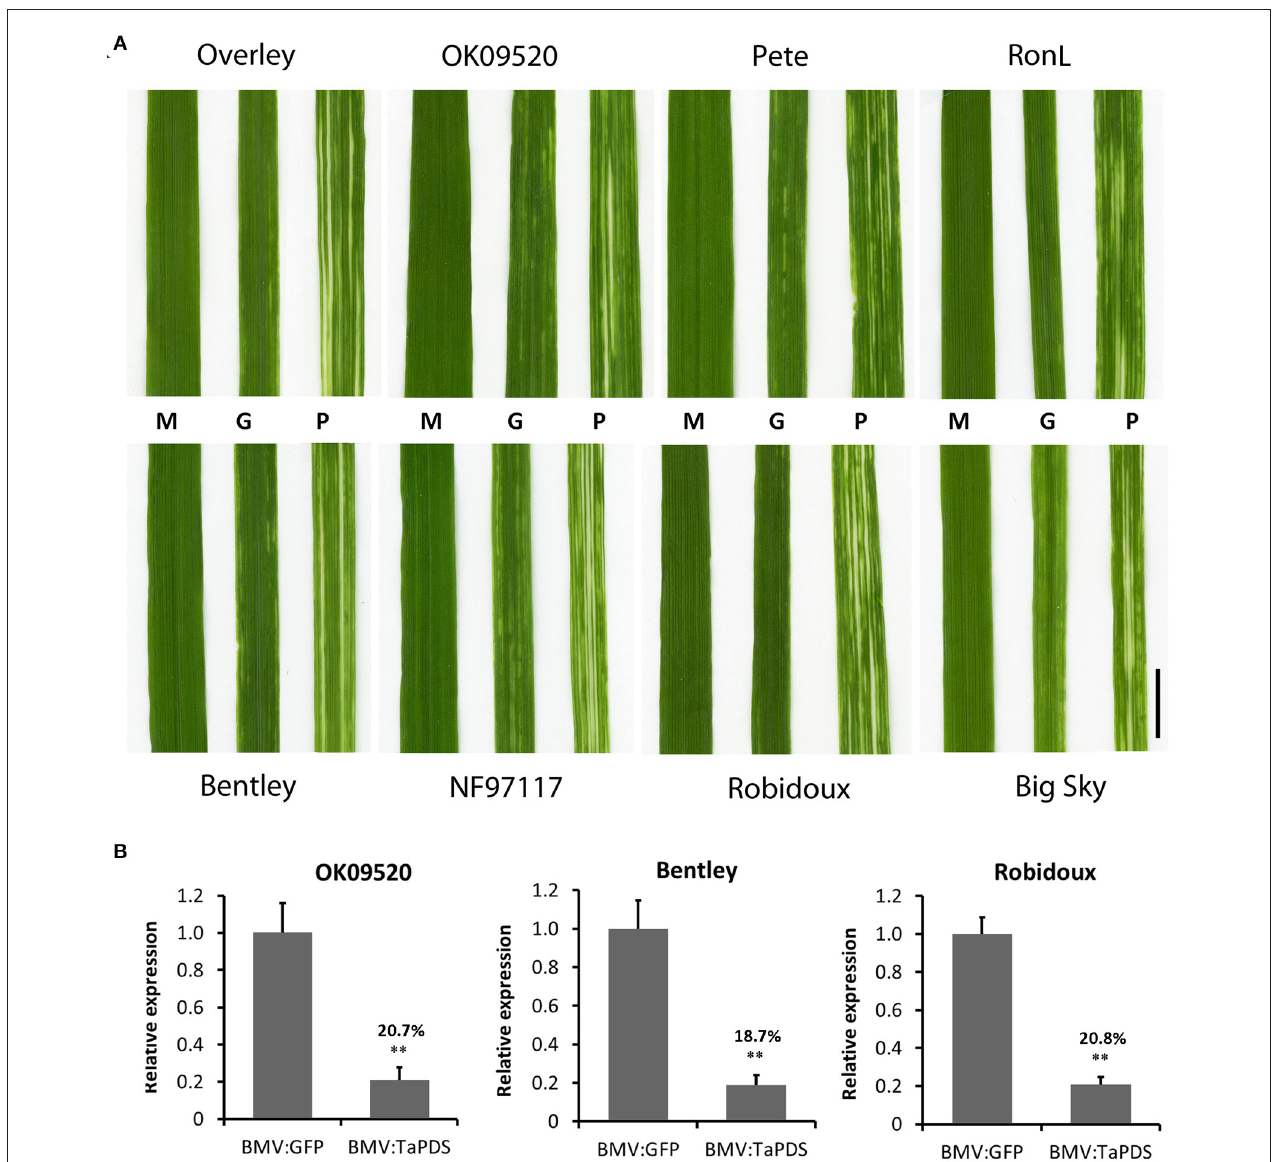
FIGURE 7 | BMVCP5-induced TaPDS silencing in eight winter wheat cultivars. (A) Images show a representative phenotype of the 3rd systemic leaf at 22 dpi from plants infected with mock (M), BMV:eGFP 107 (G) or BMV:TaPDS 100 (P). Bar = 1cm. (B) TaPDS mRNA expression levels in the 3rd systemic leaf at 22 dpi from